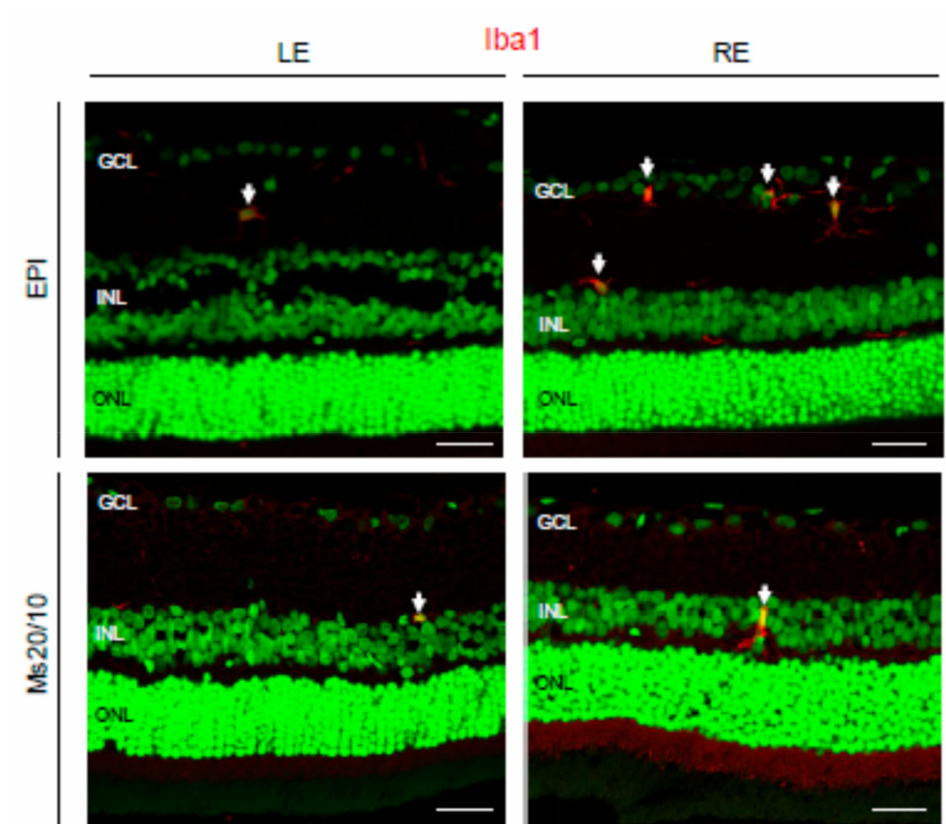
Figure 10. Ionized calcium-binding adaptor molecule 1 (Iba1) expression in the glaucomatous EPI and Ms20/10 models. Representative images showed the location of microglial cells (arrows) marked by Iba1 in the retinas. GCL: ganglion cell layer; INL: inner nuclear layer; ONL: outer nuclear layer; LE: left eye (control); RE: right eye (treated). Scale bar: 31.25 µ